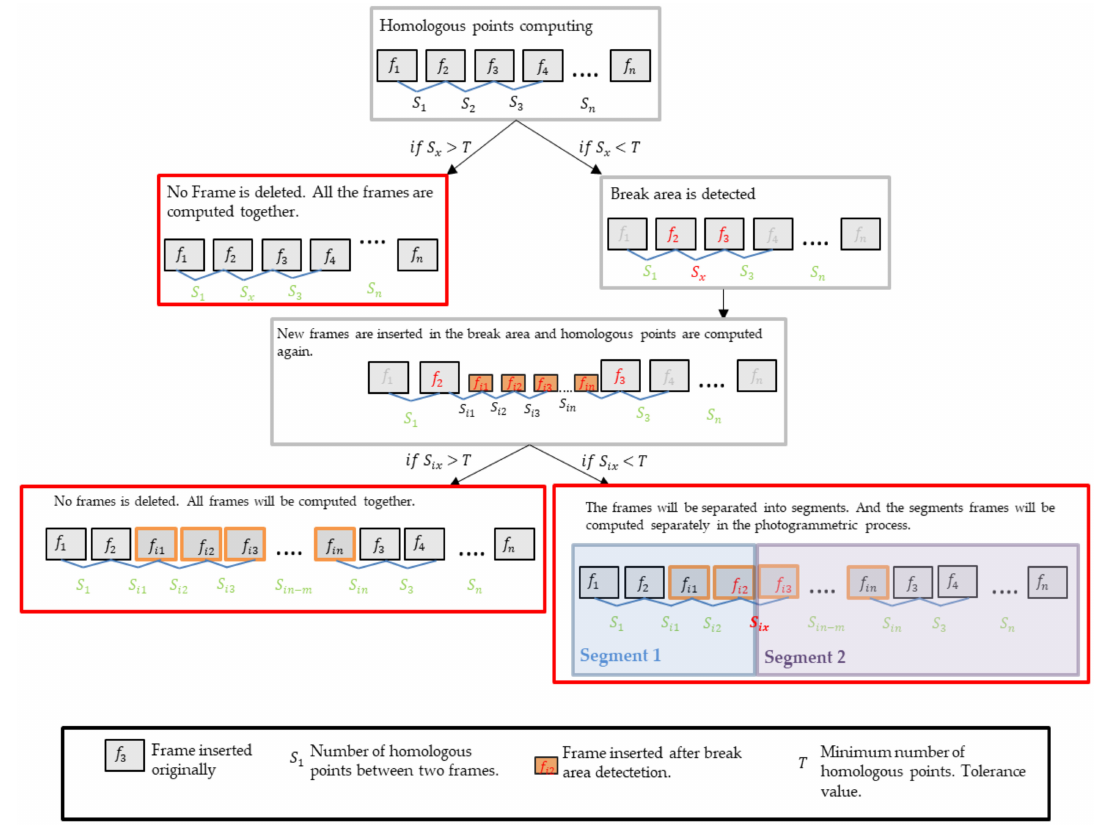
Figure 3. Break area filter